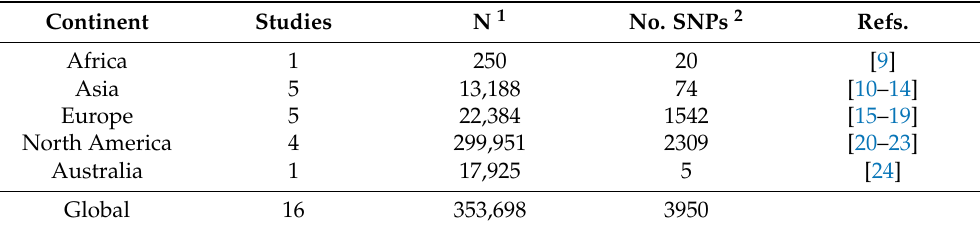
Table 4. Identified SNPs on each continent. Data extracted from scientific literature published from 2010 to